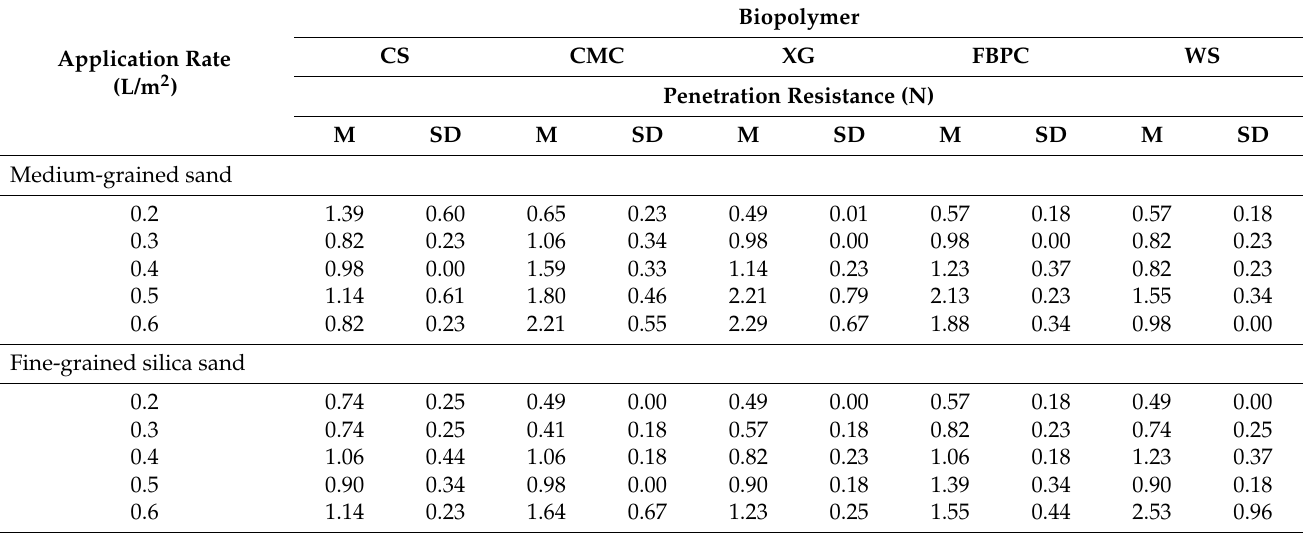
Table A5. Results of Phase 2 penetrometer tests. Penetration resistance of medium-grained sand and fine-grained silica sand samples treated at different application rates and their respective plateau concentrations. Tests were performed on day 28 after initial treatment (after the fifth and last wind tunnel cycles). Each of the three prepared samples was penetrated at the top and bottom of the centre (n =